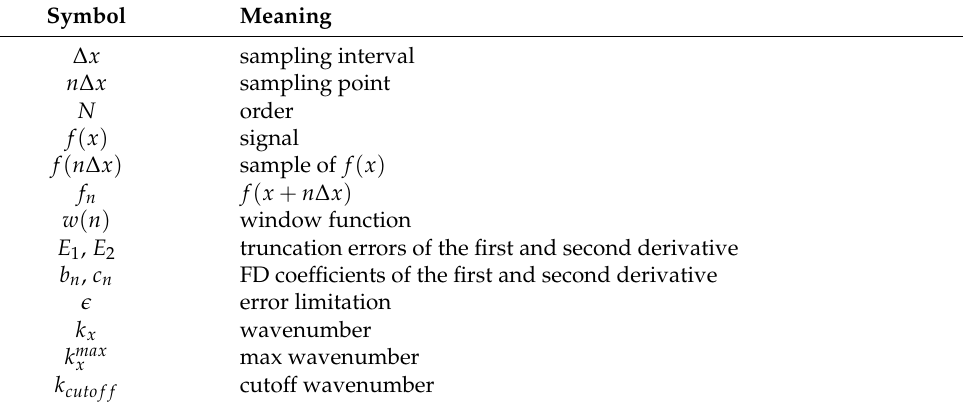
Table 1. List of